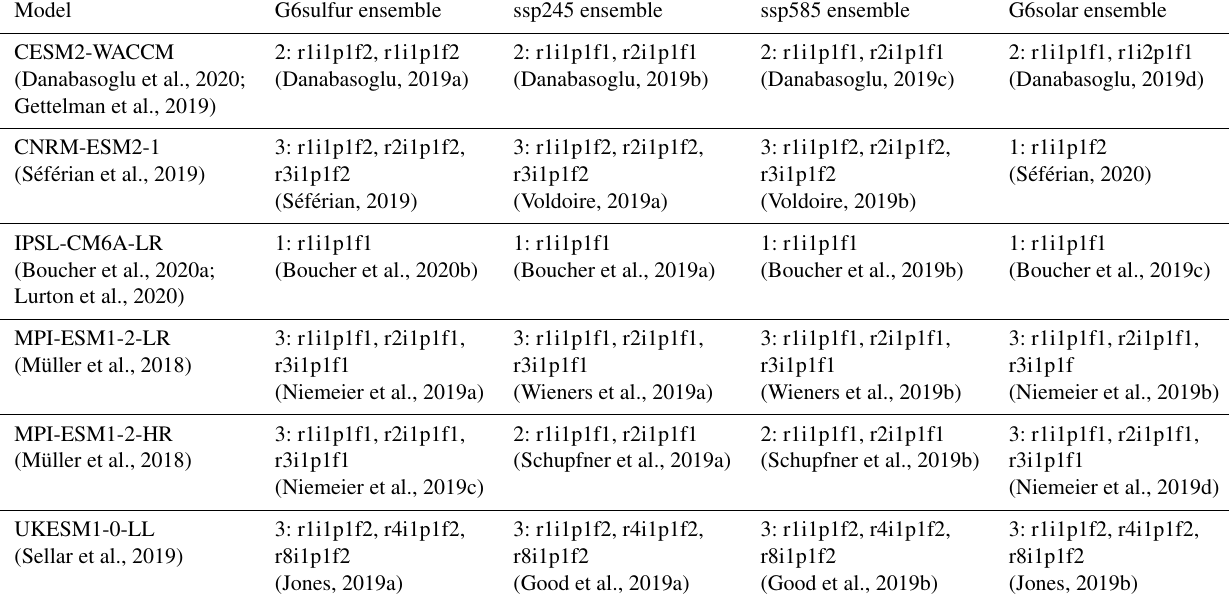
Table 1. The models used in this study with details of the experiment ensembles: the ensemble size, the identifiers of the individual simula- tions and the experiment data